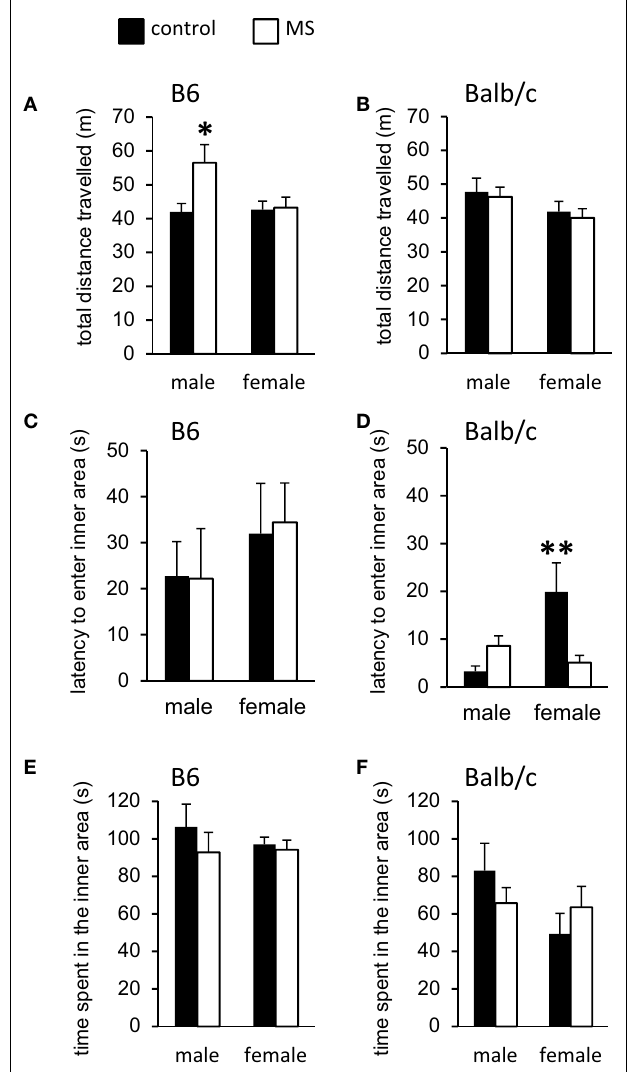
FIGURE 2 | Open-field behavioral effects of MS-rearing in B6 and Balb/c mice . Open-field activity (total distance traveled) was (A) increased in MS-reared B6 males ( p < 0.05) with (B) no effects in Balb/c mice. Latency to enter the inner area of the open-field was (C) not altered by MS in B6 mice and (D) was decreased in MS-reared Balb/c females ( p < 0.01). No effects of MS were observed on time spent in the inner area of the open-field in (E) B6 or (F) Balb/c mice. * p < 0.05, ** p < 0.01 (control vs . MS comparisons).